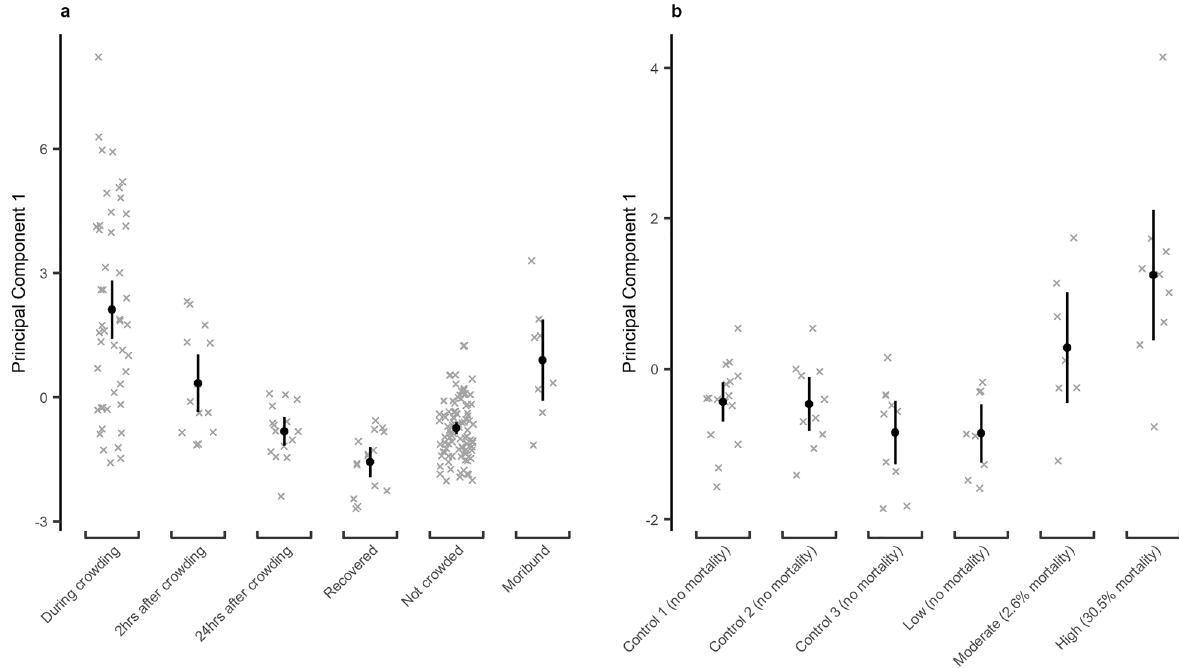
Figure 1. The relationship between treatment of Atlantic mackerel ( Scomber scrombrus ) in crowding trials and Principal Component 1 from a Hill and Smith principal component analysis. ( a ) The relationship with fish sampled at various time points during all trials. ( b ) The relationship with overall mortality rates for the different trials for fish sampled during treatment periods. Points indicate model derived mean values with 95% confidence intervals as whiskers. The underlying dataset is indicated as